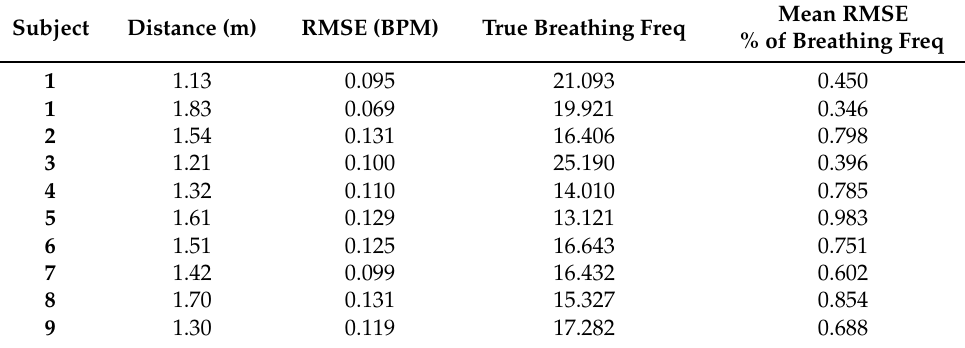
Table 5. Root mean squared error results on test subjects for ranges 1–2 m.